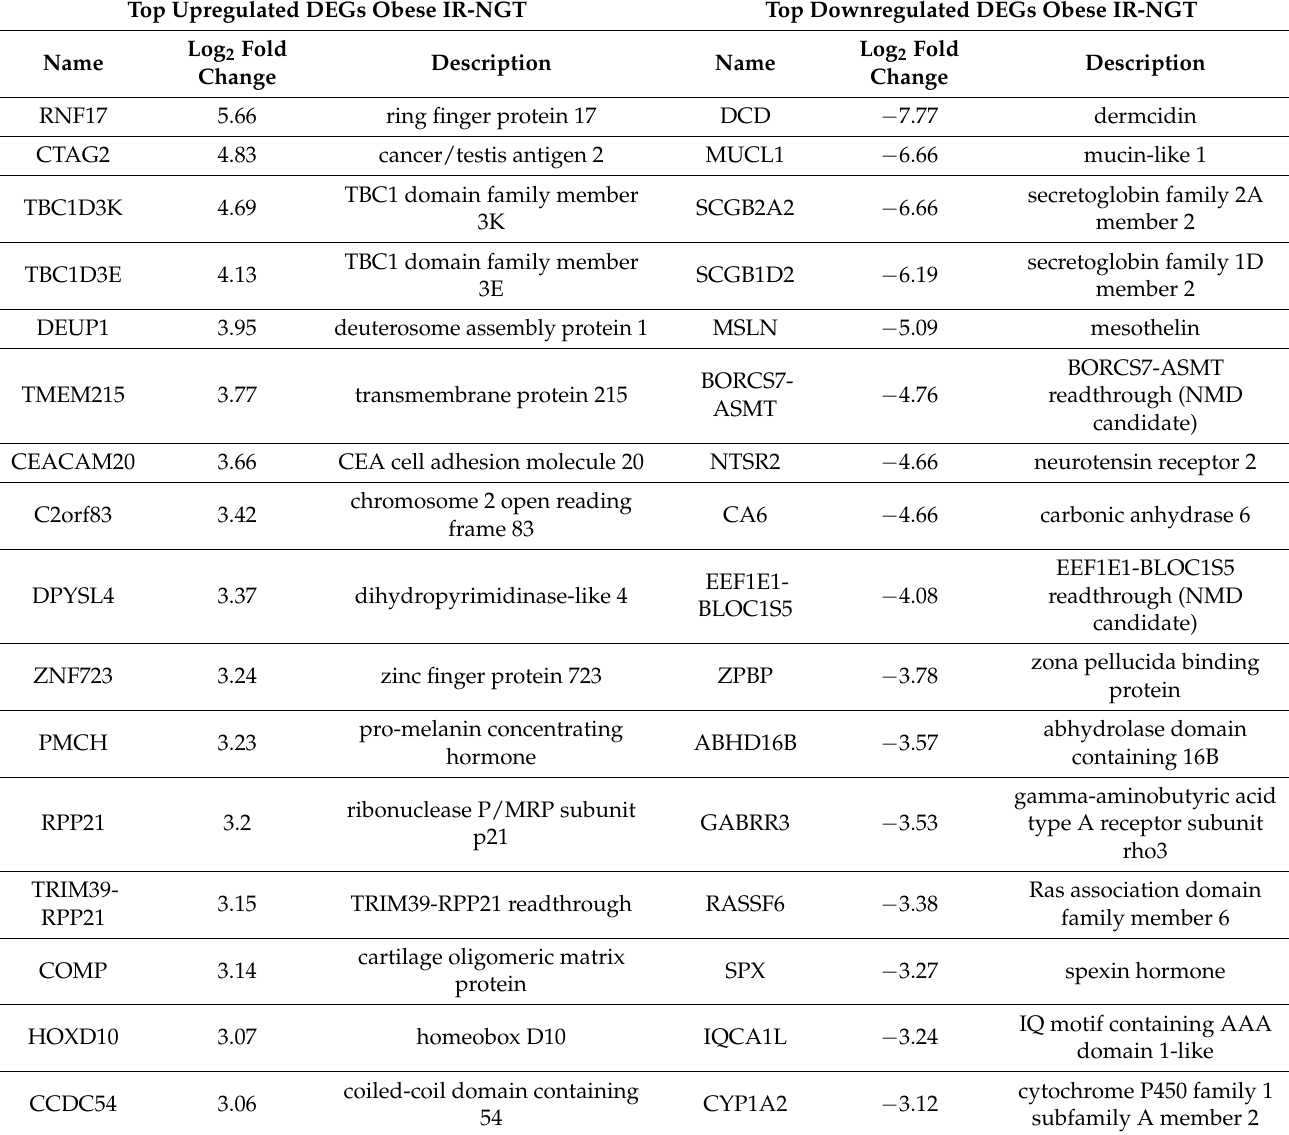
Table 1. Top 20 DEGs in obese insulin resistant—normal glucose tolerance.